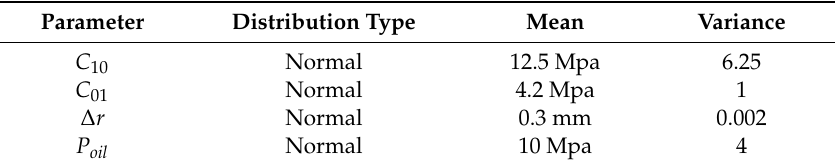
Table 1. Randomness of parameters in the rubber O-ring